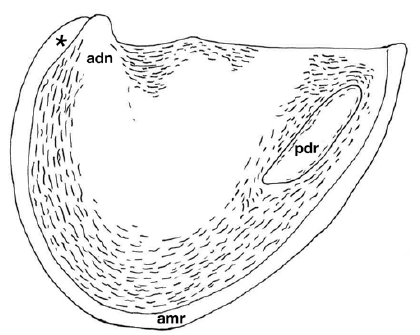
Figure 36. Cambroarchilocus tigris gen. nov. sp. nov. Reconstruction of left shield, anterior to left. Reconstruction based on both the holotype and paratype. Width of shield 1.5 mm. Abbreviations: adn , anterodorsal node; amr , admarginal rim; pdr , posterodorsal node, * = anterodorsal cardinal marginal concavity. Image Credit: Mark McMenamin.